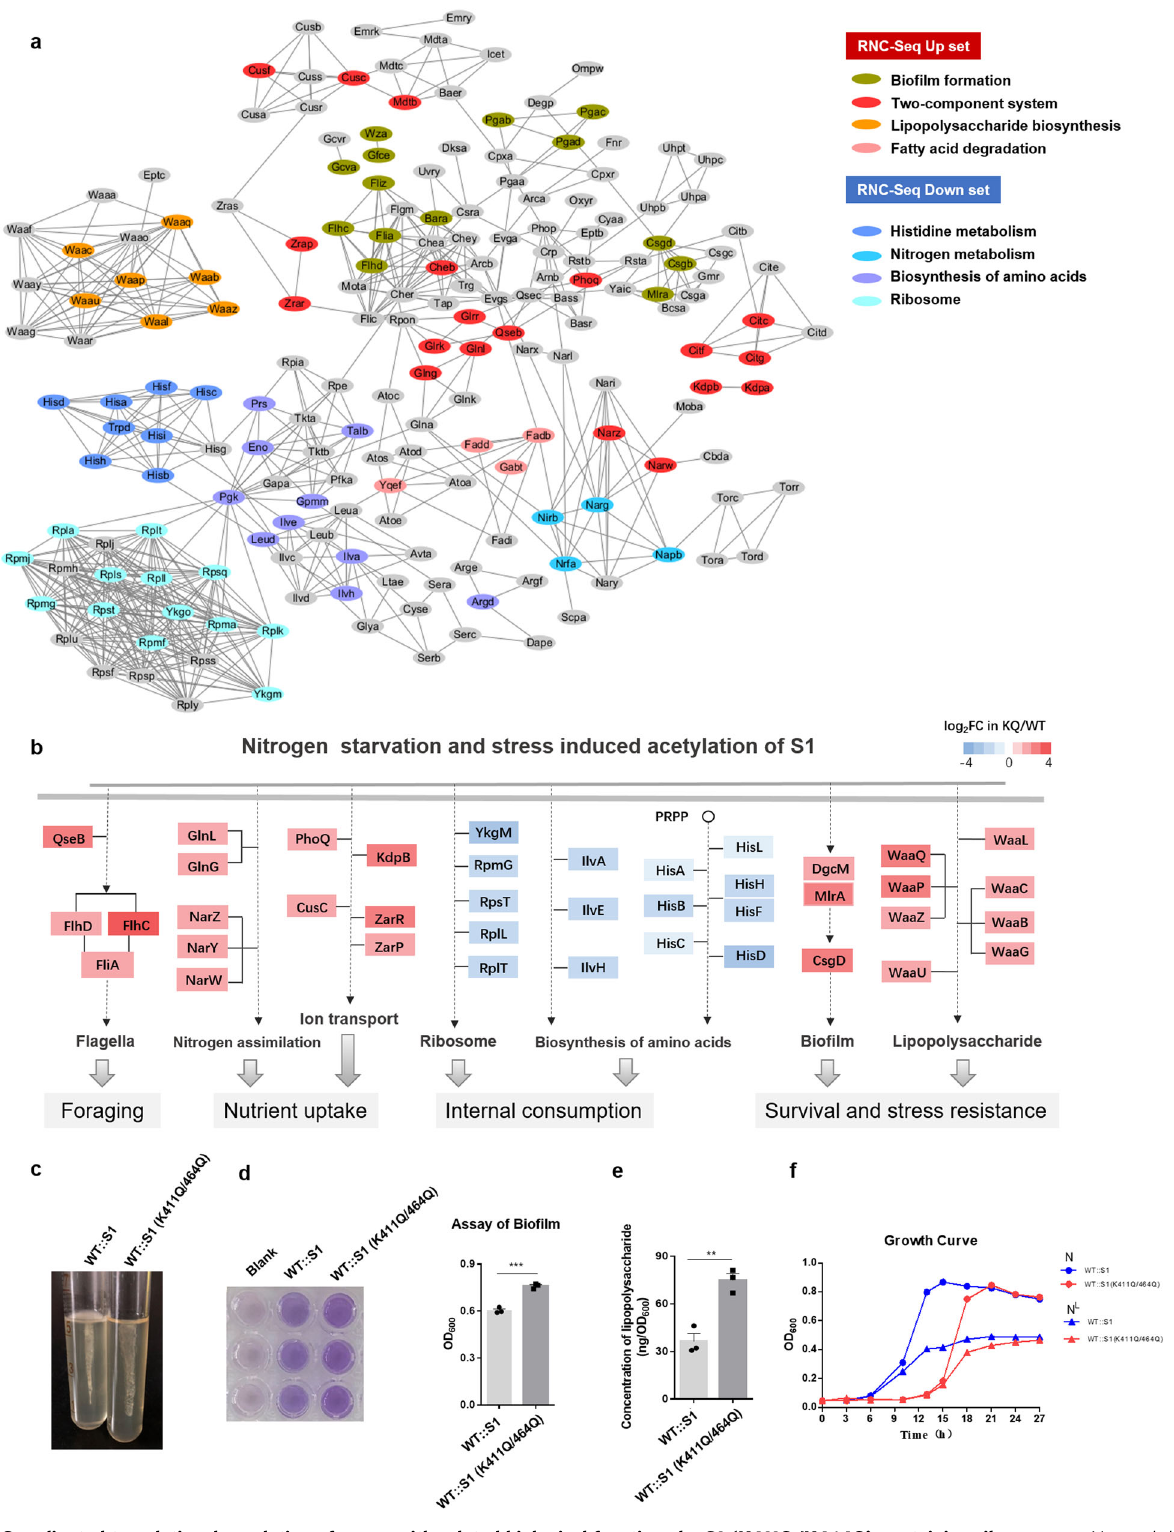
Fig. 3 Coordinated translational regulation of genes with related biological functions by S1 (K411Q/K464Q)-containing ribosomes. a Network-based cluster analysis of KQ/WT-RNC-Seq up- or downregulated genes and their associated functional classes. b Schematic diagram of signal transmission based on pathways enriched in RNC-Seq up- or downregulated genes. c Motility assay of WT::S1 and WT::S1 (K411Q/K464Q) on semisolid medium. d Bio fi lm assay of WT::S1 and WT::S1 (K411Q/K464Q) in a 96-well microplate. * P < 0.05, ** P < 0.01, *** P < 0.001. Three replicates were made for each sample. e Lipopolysaccharide measurement of WT::S1 and WT::S1 (K411Q/K464Q). * P < 0.05, ** P < 0.01, *** P < 0.001. Three replicates were made for each sample. f Growth curves of WT::S1 and WT::S1 (K411Q/K464Q) cultured in nitrogen-rich (N) or nitrogen-limited (N L ) conditions. Three replicates were made for each